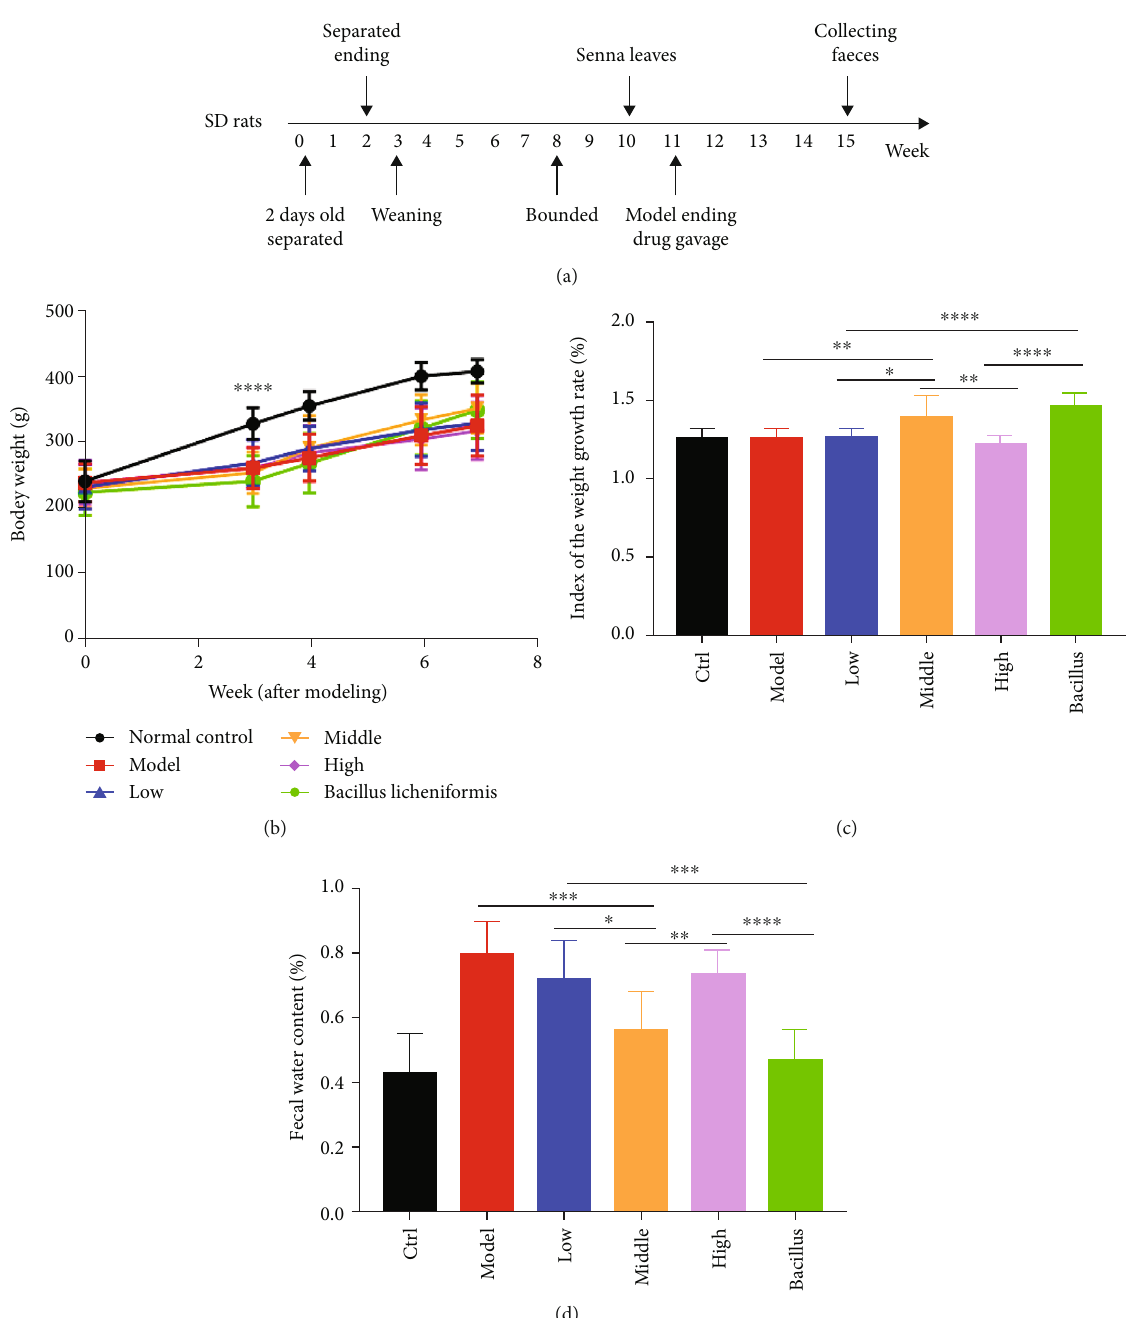
Figure 1: Evaluation of the e ffi cacy of TCM treatments on IBS-D. (a) Time axis of di ff erent experiments on rats. (b) Changes of body weight at the beginning of modeling in di ff erent groups of rats. (c) Index of the weight growth (the ratio of body weight at the end of treatment to that before treatment) in rats. (d) Fecal water content in rats from each group after treatment ð Fecal weightbeforedrying − fecal weight after drying Þ /weightbefore drying . n = 10 /group. Error bars represent SD. Statistical di ff erences between every two groups were estimated by an unpaired t test, ∗ P < 0 : 05 , ∗∗ P < 0 : 01 , ∗∗∗ P < 0 : 001 , ∗∗∗∗ P < 0 : 0001 tered from double-ended reads. At least 31,486 clean tags used 16S rRNA sequencing to analyze fecal samples in the were generated from each sample, and an average of same period from every group to observe the characteristics 132,653 clean tags were generated. The values of good cover- of fecal microbiota in IBS-D rats and role of di ff erent TCM age were nearly 99.9% for all sequences in these two groups concentrations in IBS-D. A total of 6,362,935 pairs of reads so that sequencing depth will be su ffi cient for investigating were obtained by sequencing from 38 samples, and a total fecal microbiota. of 5,836,724 clean tags were generated after spliced and fi l-